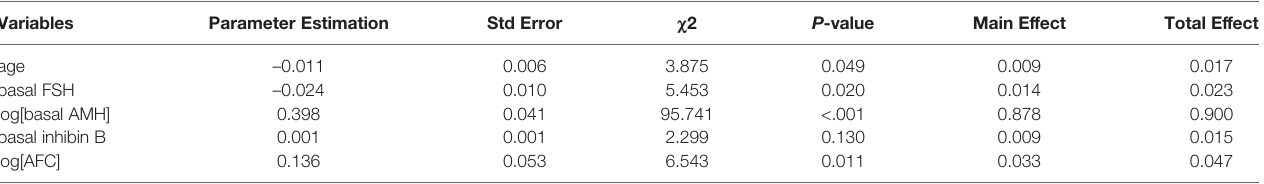
TABLE 2 | Model-1 using basal predictors to predict the NOR by multiple negative binomial regression.